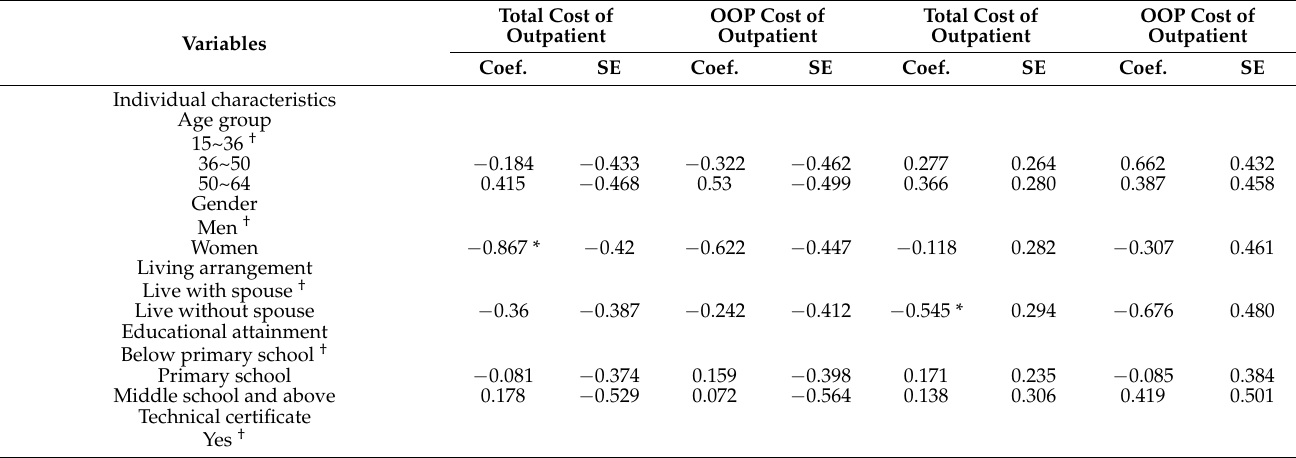
Table 5 presented the adjusted associations between health service utilization of rural migrant workers with NCMS and its determinants. The significant influencing factors of the total cost of two-week outpatient migrant workers included gender and city service quality index. The total cost of female rural migrant workers was lower than that of men (Coef. = − 0.867, p < 0.05). There is a positive relationship between the city service quality index and the total cost of the two-week outpatients (Coef. = 0.904, p < 0.05). The significant influencing factors of the OOP cost of the two-week outpatient migrant workers included the type of industry and the per capita annual income. The OOP cost of two weeks working in collective enterprises and institutions was significantly lower than those in Party/government/state-owned enterprises and institutions (Coef. = − 1.760, p < 0.05). There is a positive relationship between the per capita annual income and the OOP cost of two-week outpatients (Coef. = 1.04 × 10 − 10 , p < 0.05). The significant influencing factors of the total cost of inpatient of migrant workers included marital status, health self-assessment and the community health index. The total cost of inpatient of rural migrant workers with spouses was significantly higher than rural migrant workers without spouses (Coef. = − 0.545, p < 0.05). The total cost of inpatient of rural migrant workers with poor self-assessment was significantly higher than that of migrant workers with better self-assessment (Coef. = 0.513, p < 0.05). There is a positive relationship between the community health index and the total cost of two-week outpatients (Coef. = 0.541, p < 0.05). The OOP cost of inpatient of participating migrant workers with the number of Friends >= 11 was significantly lower than those with the number <= 5 (Coef. = − 1.015, p < 0.05). Table 5. Association of independent variables and health service utilization